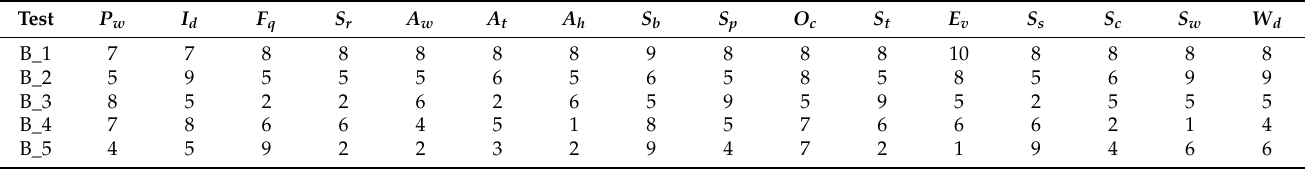
Table 5. Orthogonal test parametric arrangement for sprinkler drip irrigation in sandy soil.